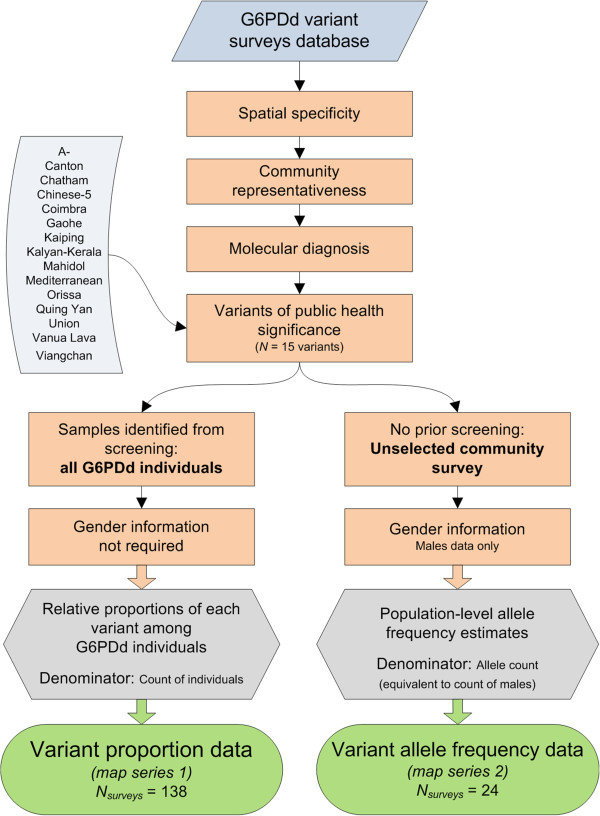
Survey inclusion criteria and G6PDd variant map outputs. Orange rectangles indicate the exclusion criteria, grey hexagons summarize the two final input data, and green rods represent the two map types.